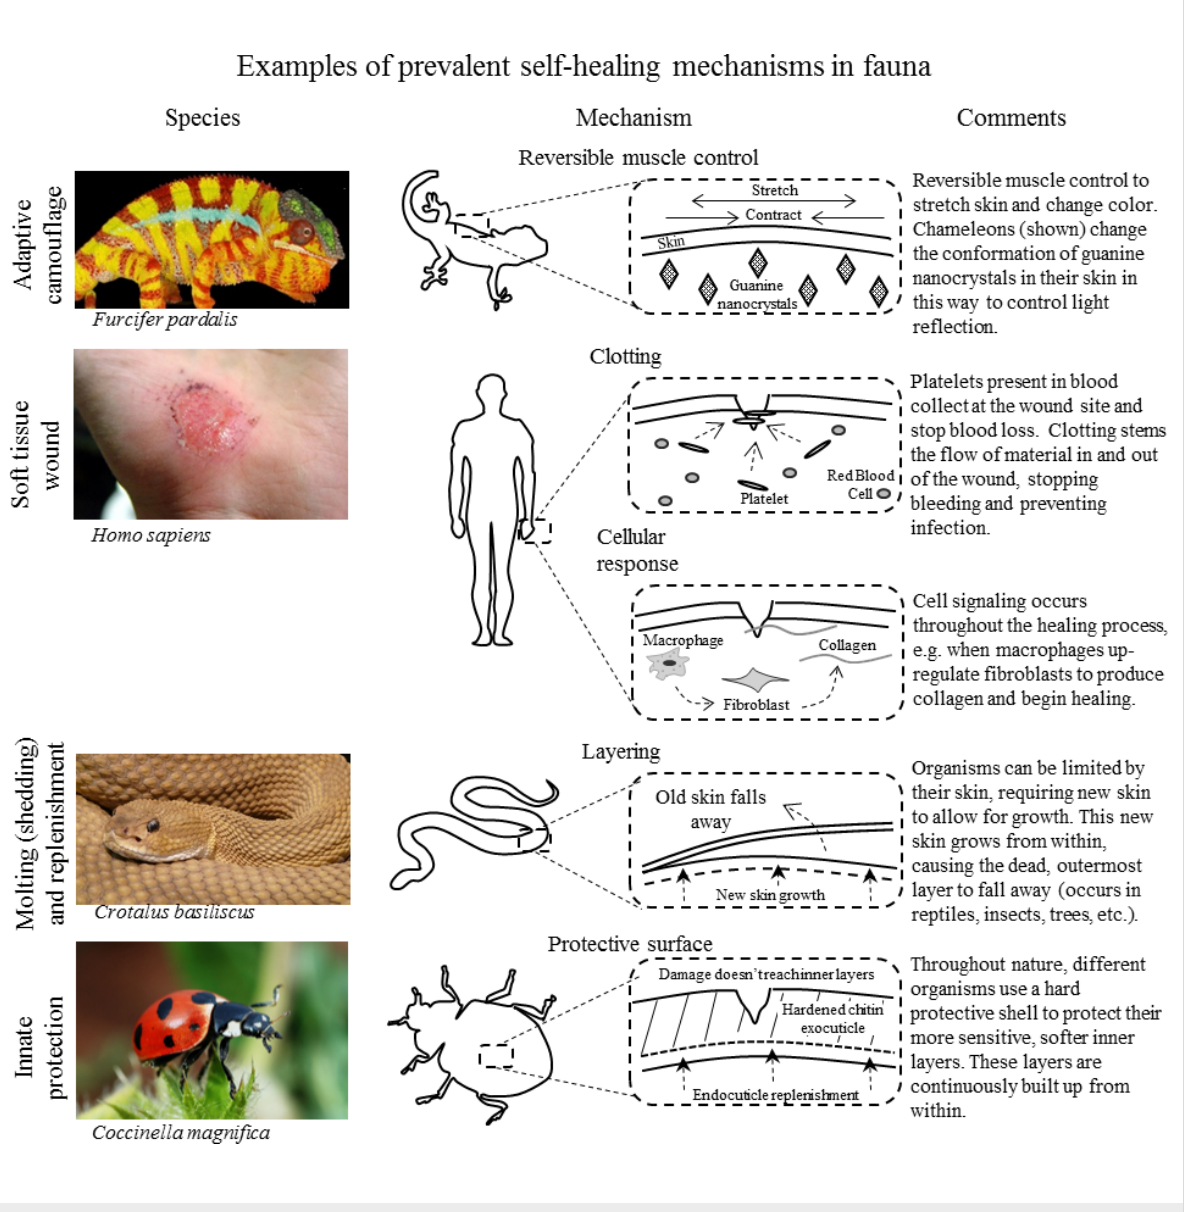
Figure 9: Examples of prevalent self-healing mechanisms found in fauna showing reversible muscle control in chameleons, clotting and cellular responses in humans, shedding in snakes, and innate protection in ladybugs. Each example is given with an illustration and description of the overall mechanisms. The top left image was reproduced from [15]. The second image on the left was reproduced from [7]. The bottom left image was repro- duced from [77], copyright 2009 under CC-BY-SA 2.0 license